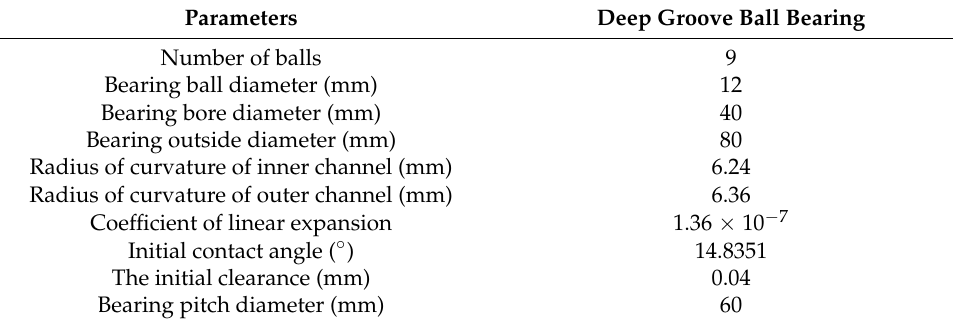
Table 1. Parameters of the deep groove ball